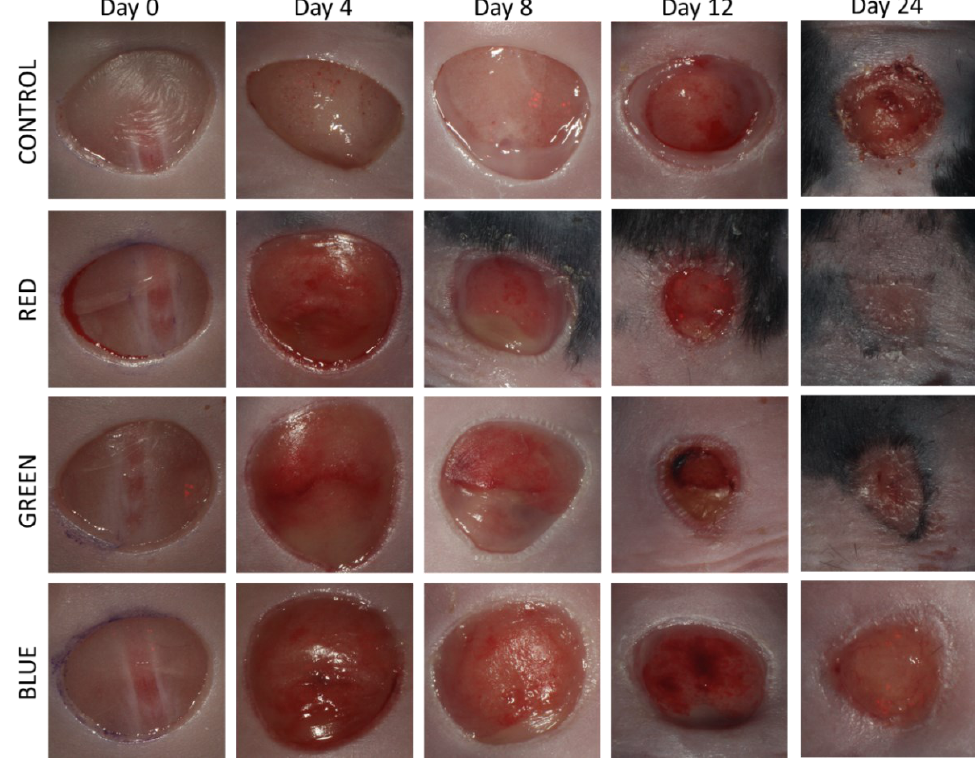
Figure 1. Typical progression of wound healing in untreated control animals and of wounds treated with pulsed LED photobiomodulation with red, green or blue light, respectively.